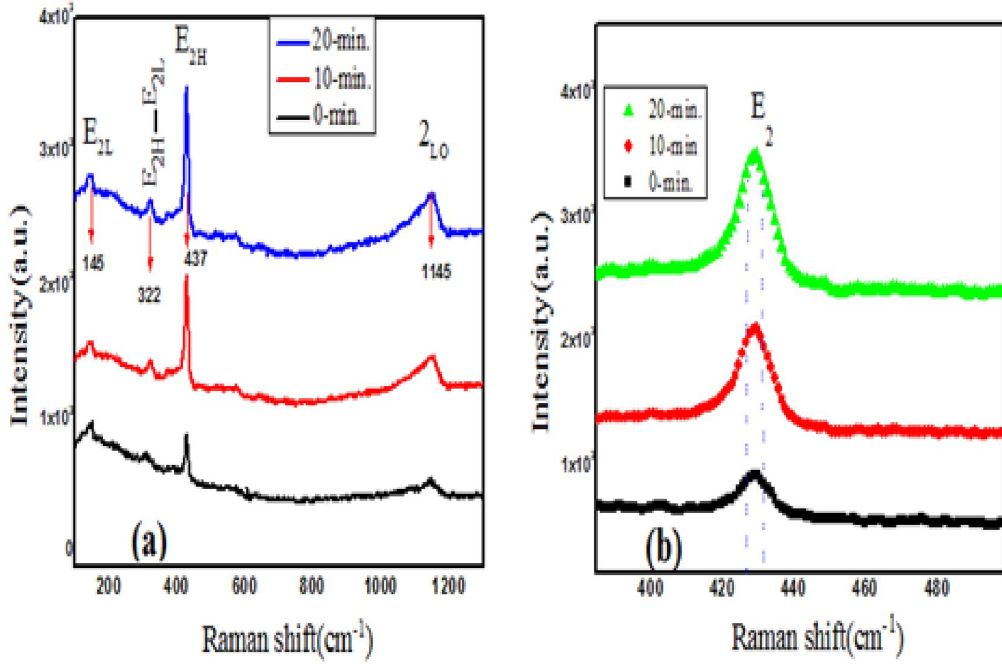
Figure 7. ( a ) Raman spectra of as-grown and irradiated ZnO-CdO coated films. ( b ) Shifting of E 2(H) phonon mode films at (0-min, 10-min and 20-min)